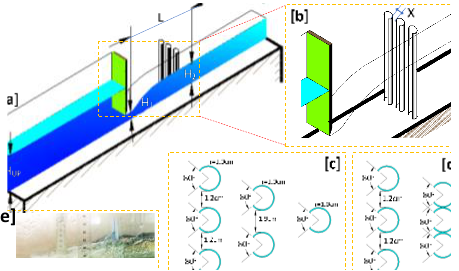
Figure 11: The Figure 12: The Figure 13: The relationship relationship relationship between 𝐻 2 and F between 𝐿 and F between ∆𝐸 and F 𝐻 1 𝐻 1 𝐸 1 for X/H 1 =0.0 for X/H 1 =0.0 for X/H 1 =0.0 The relationships between the different features of the studied free H. jumps ( 𝐻 2 , 𝐿 and ∆𝐸 ) are plotted versus the factor defined by Froude 𝐻 1 𝐻 1 𝐸 1